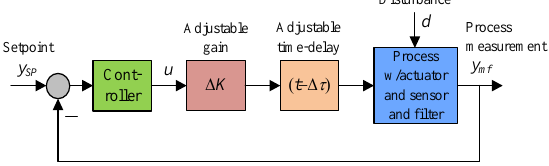
Figure 1: An adjustable gain and time-delay are in- serted into the loop to find the stability margins (gain margin and phase margin)